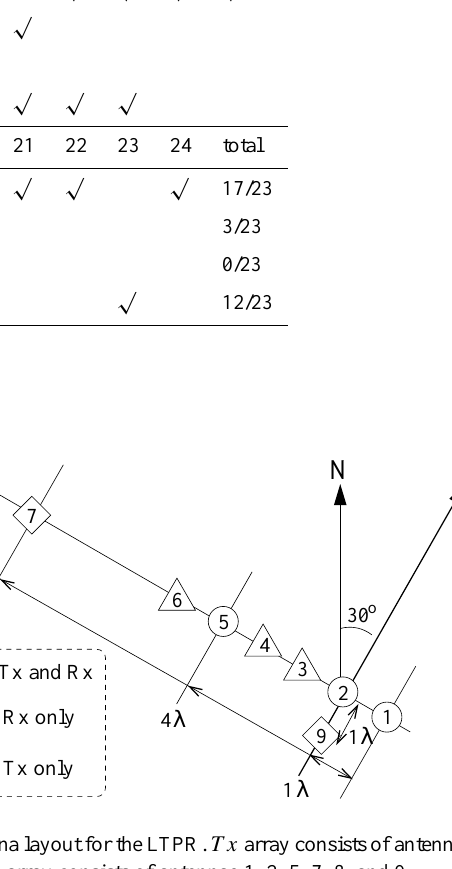
FAI occurrences as a back-up to the